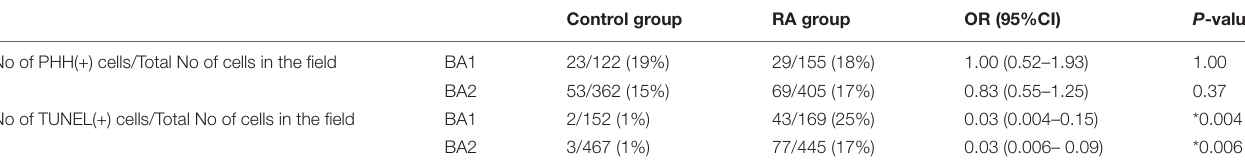
TABLE 1 | Cell proliferation and cell death in ISLET1 positive cells in the developing branchial arches (BA). Control group RA group OR (95%CI) P